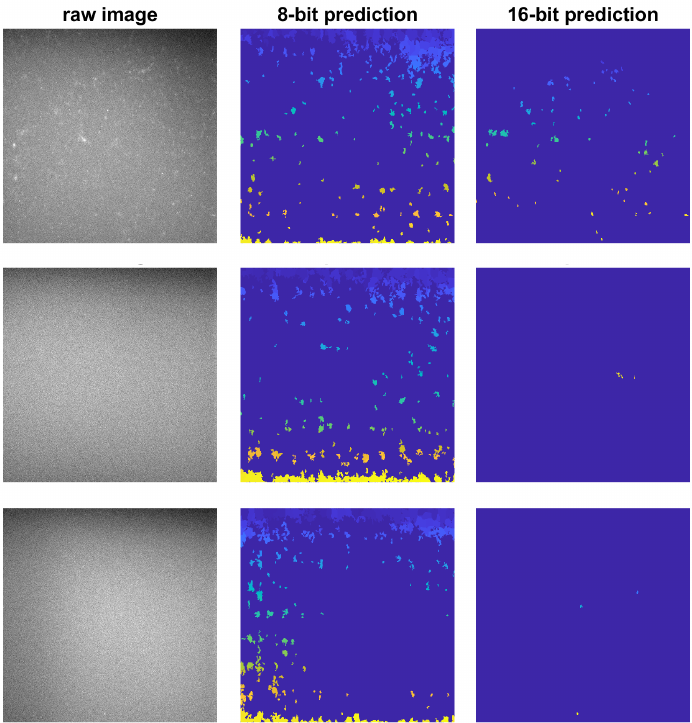
Figure 7. Three images from the Caicedo et al. dataset [10] with zero Dice, AJI and PQ scores. There were no nuclei in the ground truth segmentation masks for these three cases.